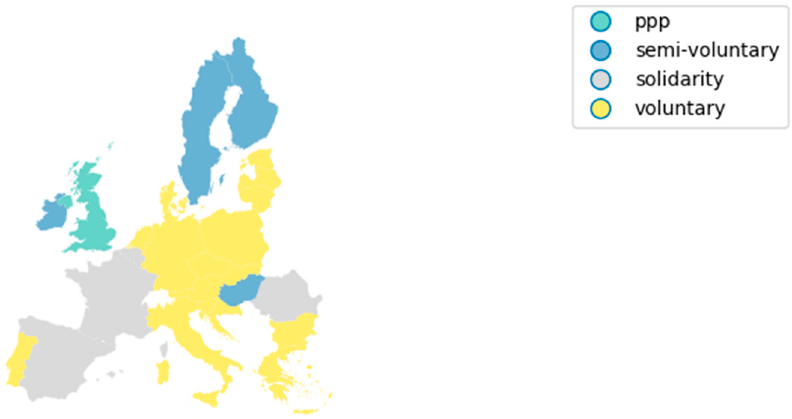
Figure 1. Stylized version of current flood insurance systems in EU countries. The voluntary system has risk-based premiums, private reinsurance, and a voluntary uptake; the semi-voluntary system is similar except uptake is required for a mortgage; the solidarity system has a mandatory uptake and no premium differentiation; the public–private partnership (ppp) has a mandatory uptake, limited risk-based premiums and a public reinsurer.